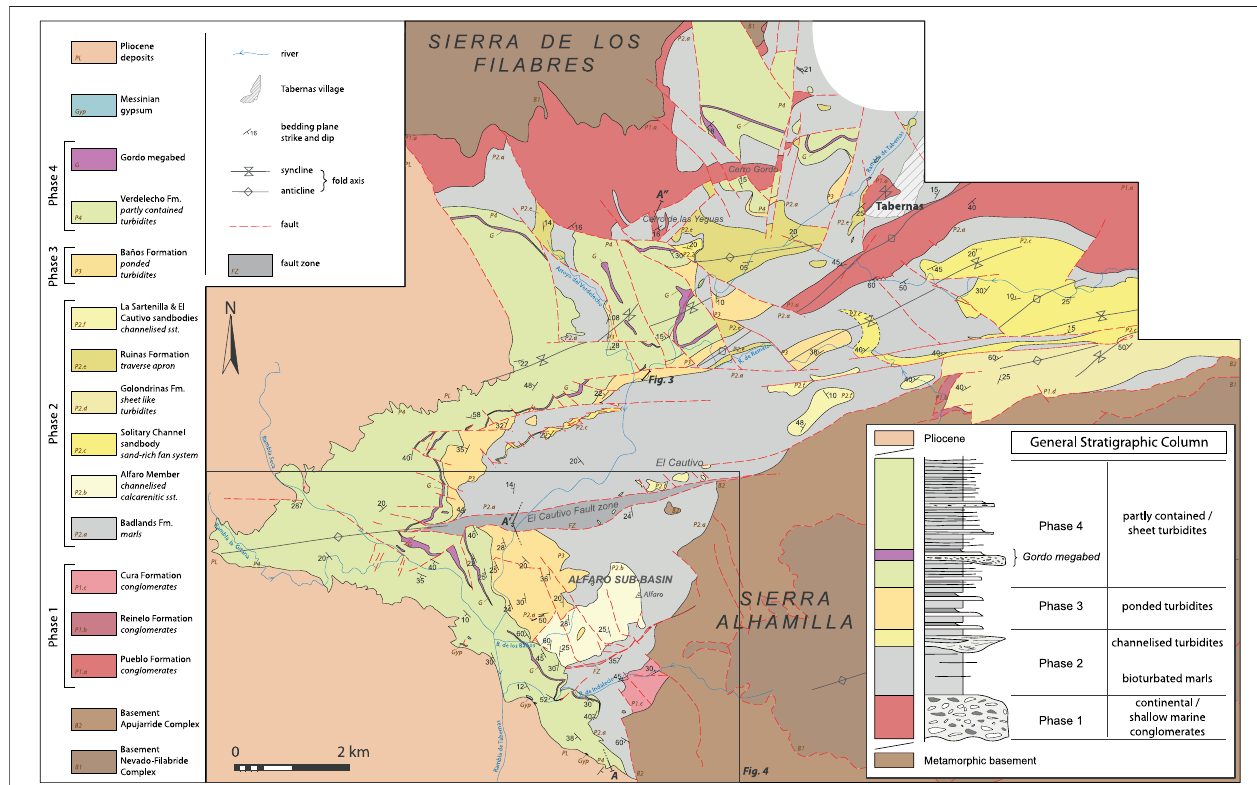
FIGURE2| Geological mapoftheTabernas Basinbased onremappingshowingthedistributionofthedifferentformationsand sandbodies and thelocationofthe Alfaro sub-basin. The inset shows a schematic stratigraphic column for the Neogene fi ll of the Tabernas Basin fi ll. A-A ′ -A ″ refers to the location of the cross-section shown in Figure 3 ; the location of Figures 4 – 6 are also indicated on the